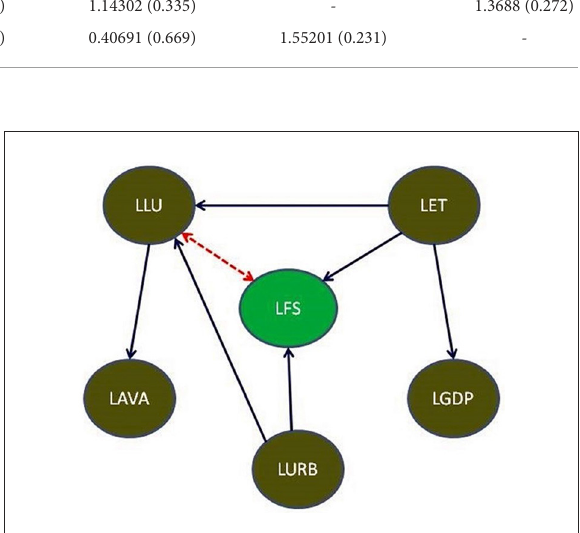
FIGURE4 Pairwise panel granger causality